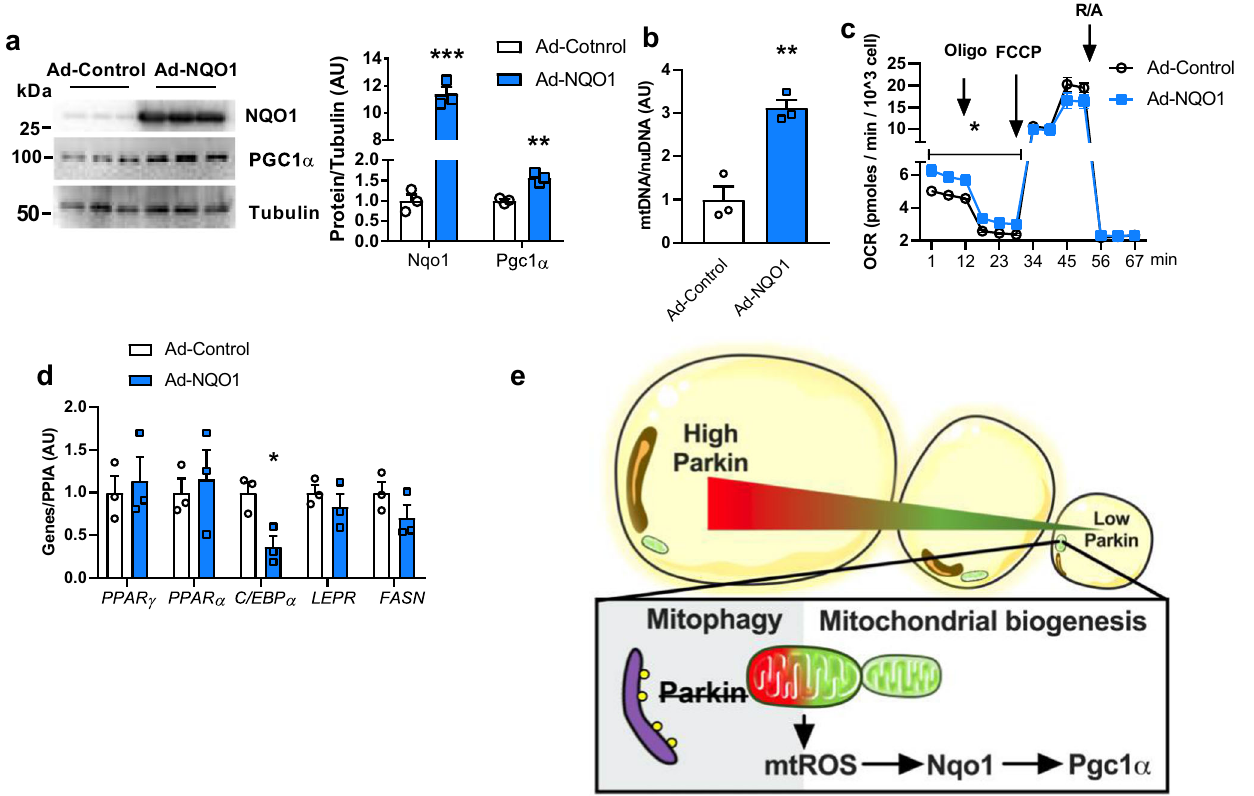
Fig. 7 | Overexpression of NQO1 in human SubQ adipocytes elevates mtDNA contentandimprovesmitochondrialfunction.a Westernblotanddensitometry analysis of Nqo1 and Pgc1 α protein levels in ad-Control and ad-NQO1 treated pri- mary human subcutaneous adipocytes ( n =3 biological replicate) [Unpaired Stu- dent ’ s t test two-tailed. For Nqo1, p <0.0001, 95%CI=18.824 – 11.90, R squared=0.9887; for Pgc1 α , p =0.0024, 95%CI=0.3372 – 0.7968, R squared= 0.9215]. b – d mtDNA content, mitochondrial oxygen consumption rate, and adi- pogenesis gene expression of ad-Control and ad-NQO1 treated primary human subcutaneousadipocytes( n =3biologicalreplicate)[UnpairedStudent ’ s t testtwo- tailed. For mtDNA Ad-Control vs. Ad-NQO1, p =0.0041, 95%CI=1.119 – 3.099, R